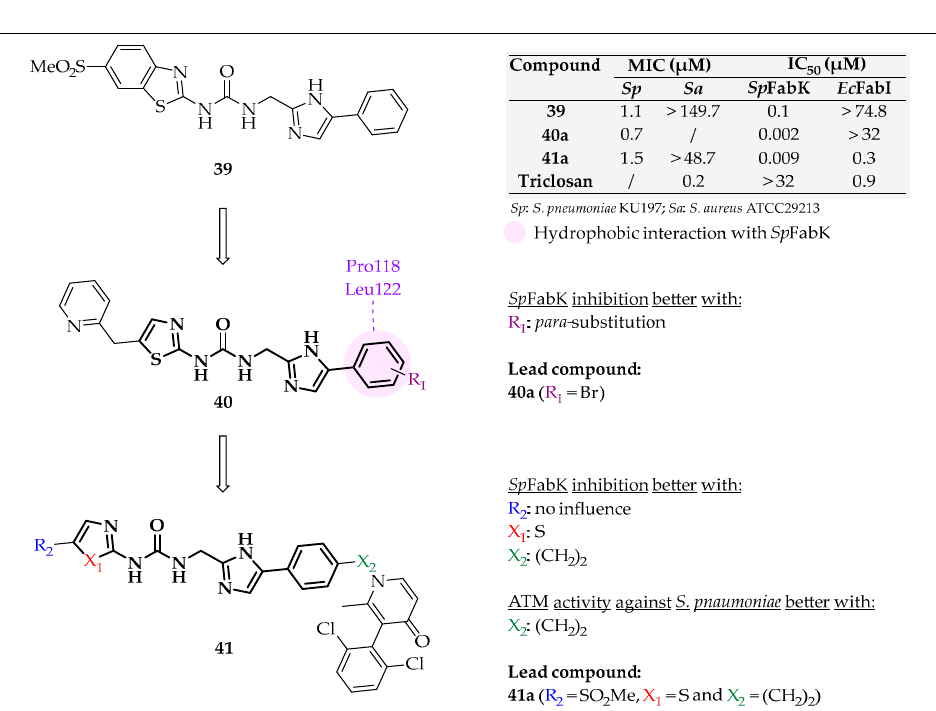
Figure 34. Structure, SAR and representation of main interactions with Sp FabK of phenylimidazole derivatives 39–41 and in vitro activities of lead compounds [158].